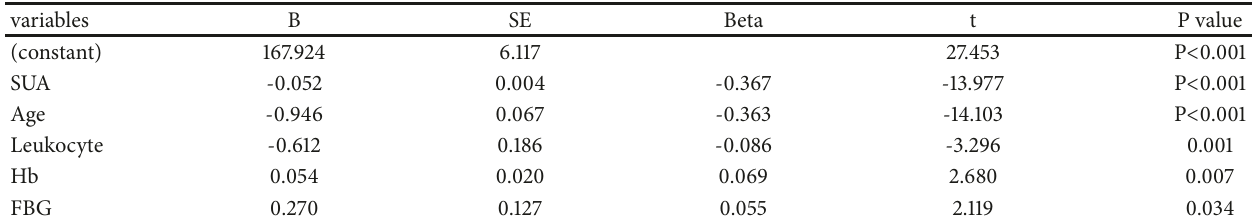
Table 5: Multiple linear stepwise regression analysis for association between eGFR and SUA in all patients.